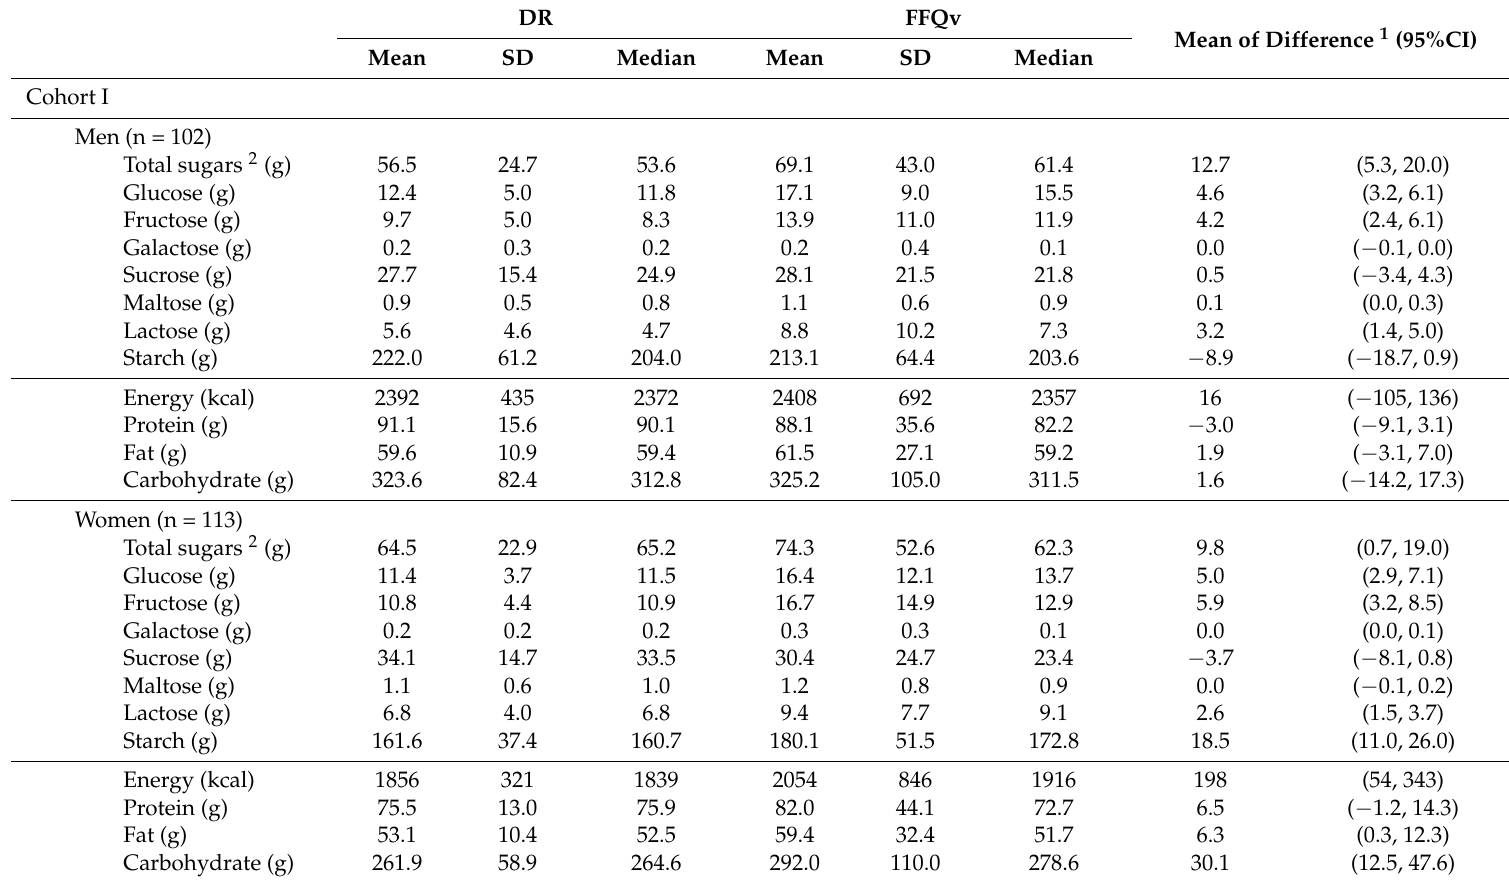
Table 2. Sugar intakes assessed with DR for 28 or 14 days and FFQv in Cohort I & II and